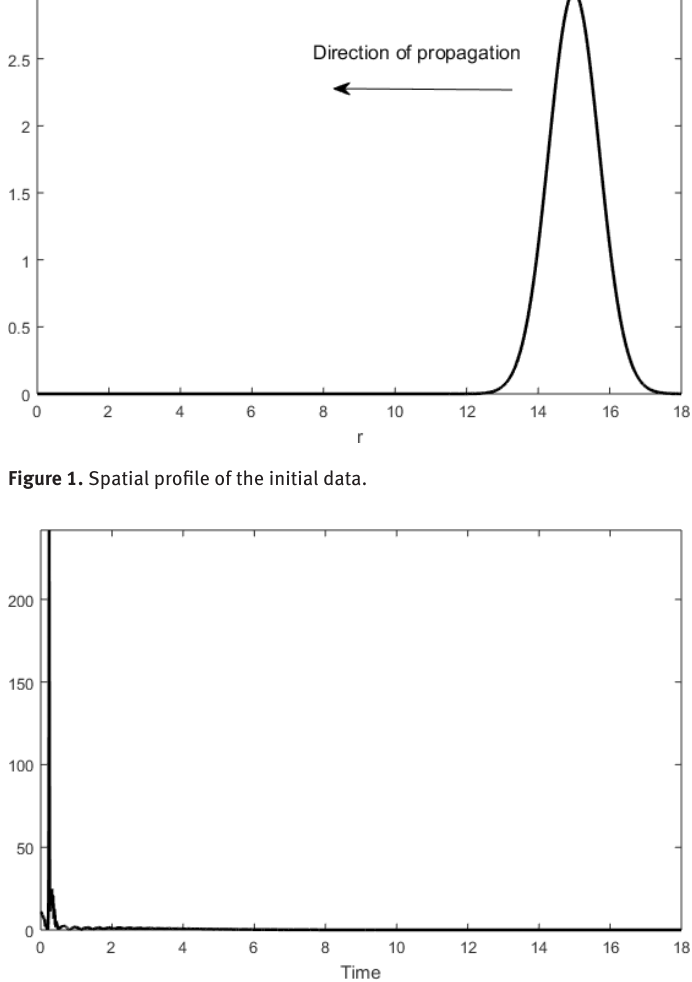
Figure 2. Formation of the singularity at T = 0.6512.